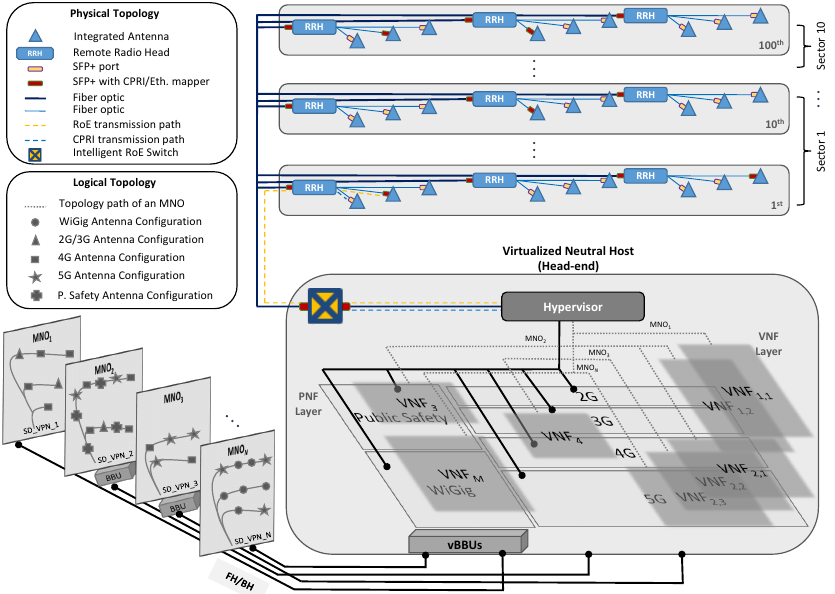
Figure 2. Illustration of the proposed 5GB neutral host design architecture utilizing RoE and vRAN